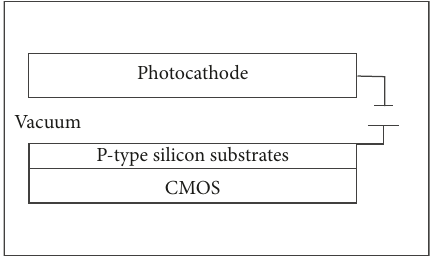
Figure 1: Structure of EBCMOS image